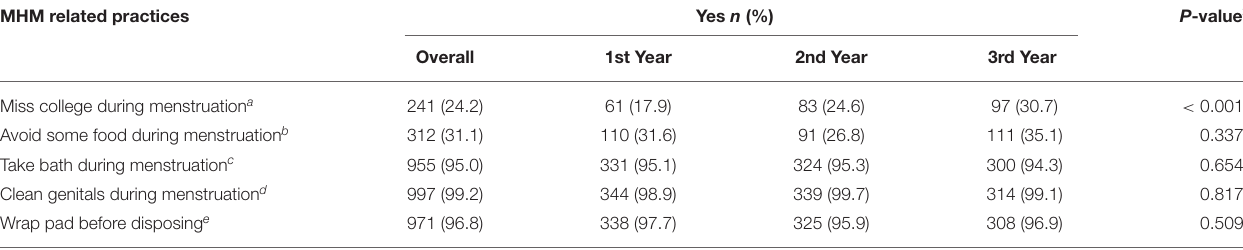
TABLE 3 | Practices related to MHM among female college students in all the 10 government colleges of Bhutan, 2018 ( n = 1,010).